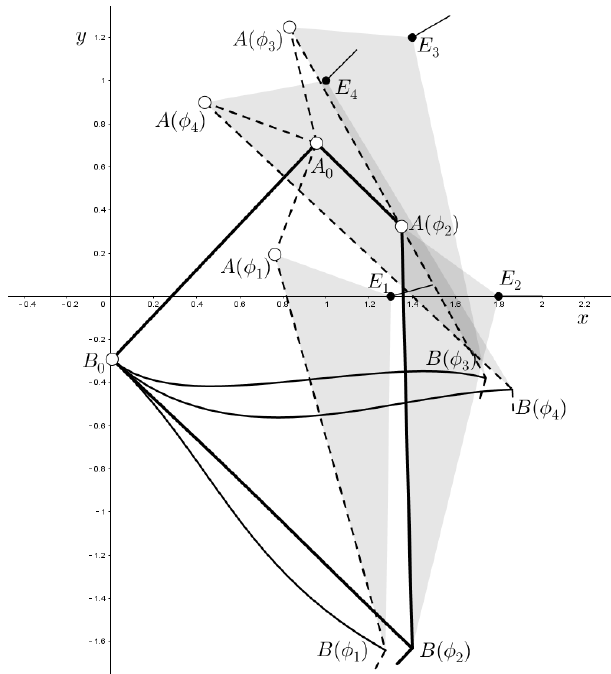
Figure 17. Solution